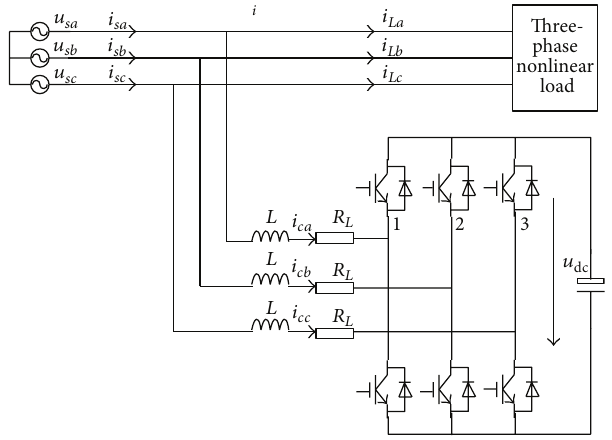
Figure 1: Structure diagram of APF converter main